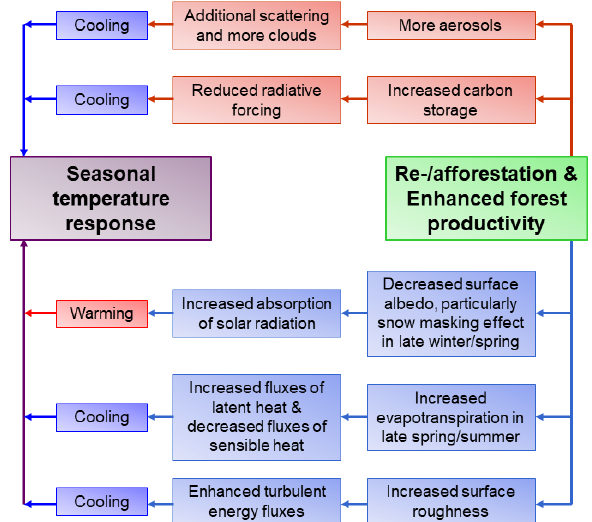
Figure 2. Outline of the biogeochemical (upper part in brown) and the biophysical (lower part in blue) influence of reforesta- tion/afforestation or enhanced forest productivity in the Baltic Sea region on near-surface temperatures. The overall effect on near- surface temperatures varies by season and region, depending, for instance, on snow cover and incoming solar radiation (adapted from May et al.,